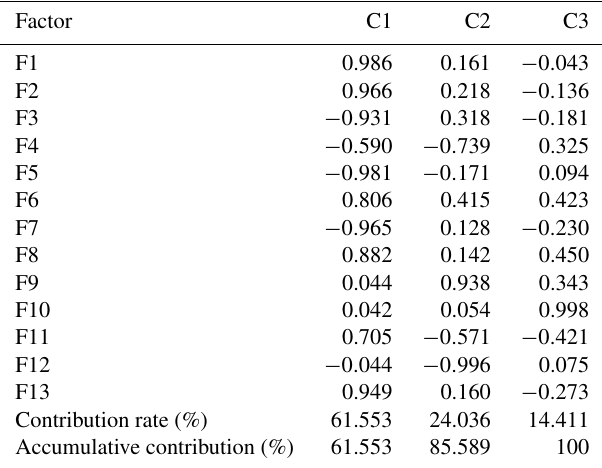
Table 8. The factor-loading matrix after rotation and contribution ratios for the third